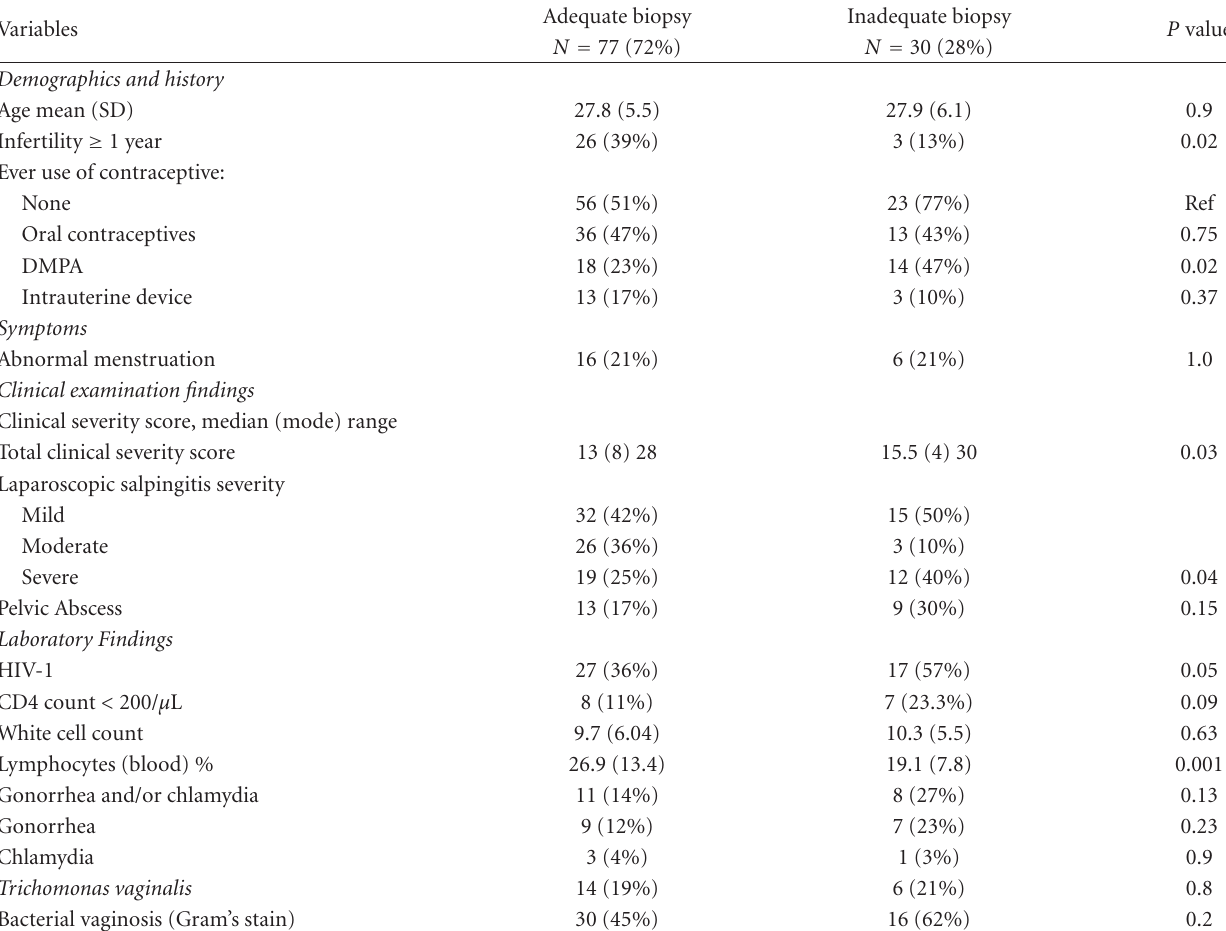
Table 2: Comparison of demographic, clinical history and signs, and laboratory findings for women laparoscopically diagnosed with salpingitis, with and without an endometrial biopsy adequate for histological